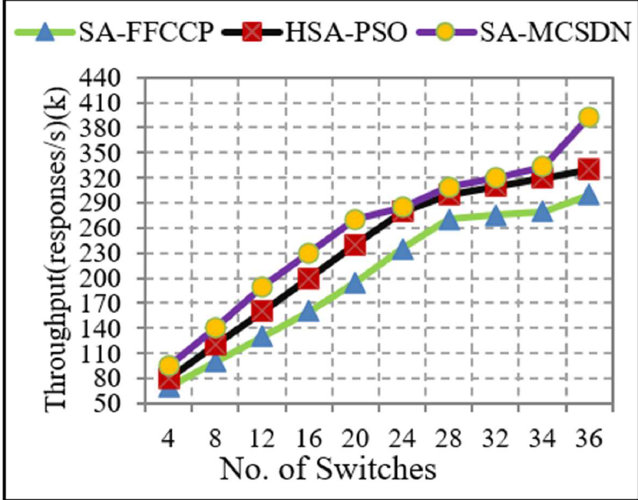
Figure 11. Comparison of throughput.